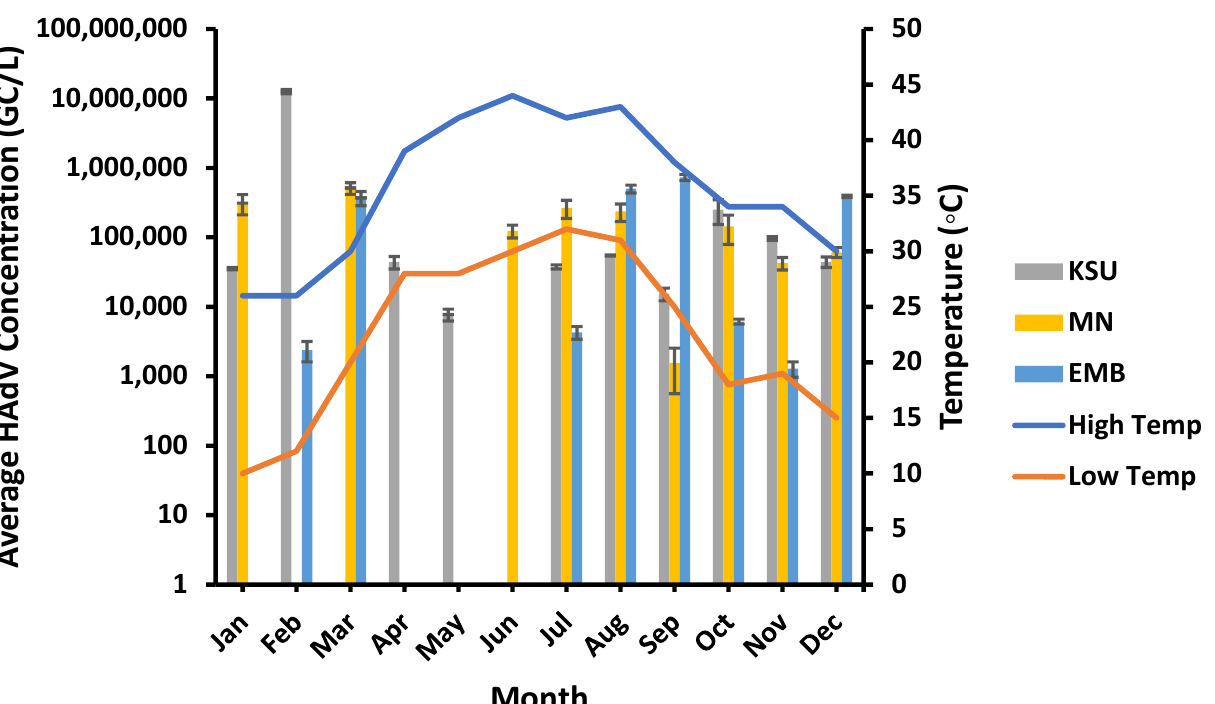
Figure 8. Temperature variation influence on the HAdV concentration in wastewater samples. “Low Temp” refers to the average low temperature, and “High Temp” refers to the average high temper- ature. Table 3. Significance of environmental factors’ influences on the concentration of HAdV .